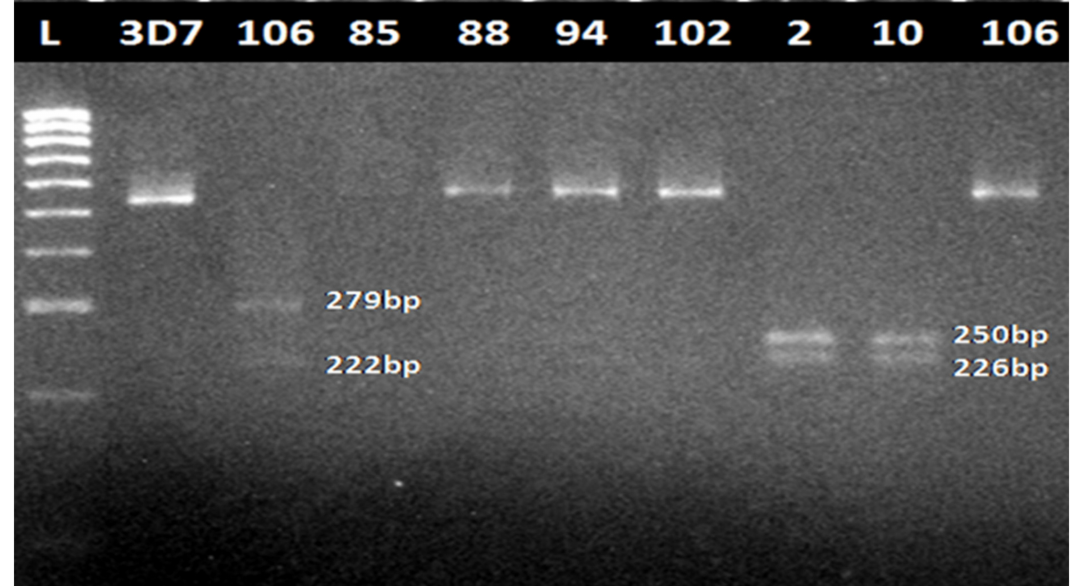
Figure 1. Photomicrograph of agarose gel showing the results of restriction fragment length polymorphism (RFLP) analysis. L is 100 bp Bioline DNA ladder [(100–1013 bp (40–200 ng/band)]; lane 2 is AflIII-negative (undigested) susceptible PF3D7 sample, lane 3 is AflIII-positive sample 106 (chloroquine-resistant (CQR) isolate), samples 88, 94, 102 are AflIII- negative, samples 2 and 10 are ApoI-positive (chloroquine-sensitive (CQS) isolates), sample 106 is ApoI-negative. Samples were digested with restriction enzymes Afl III and Apo